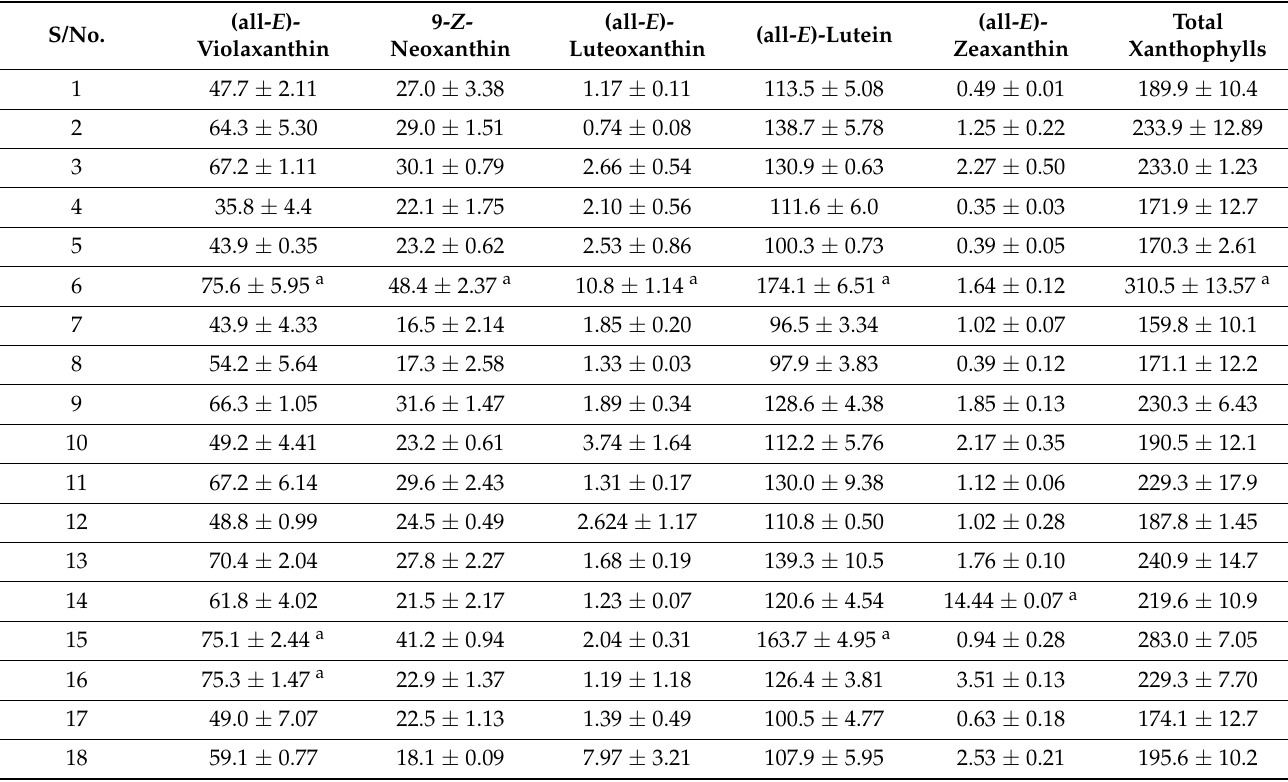
Table 3. The xanthophyll contents ( µ g/g FW) in the studied traditional GLVs.